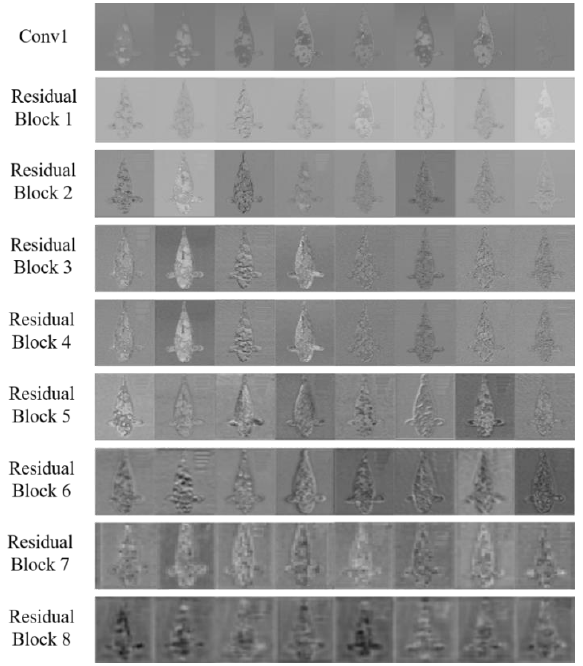
Figure 8. Activation regions of KRS-Net in a single image.